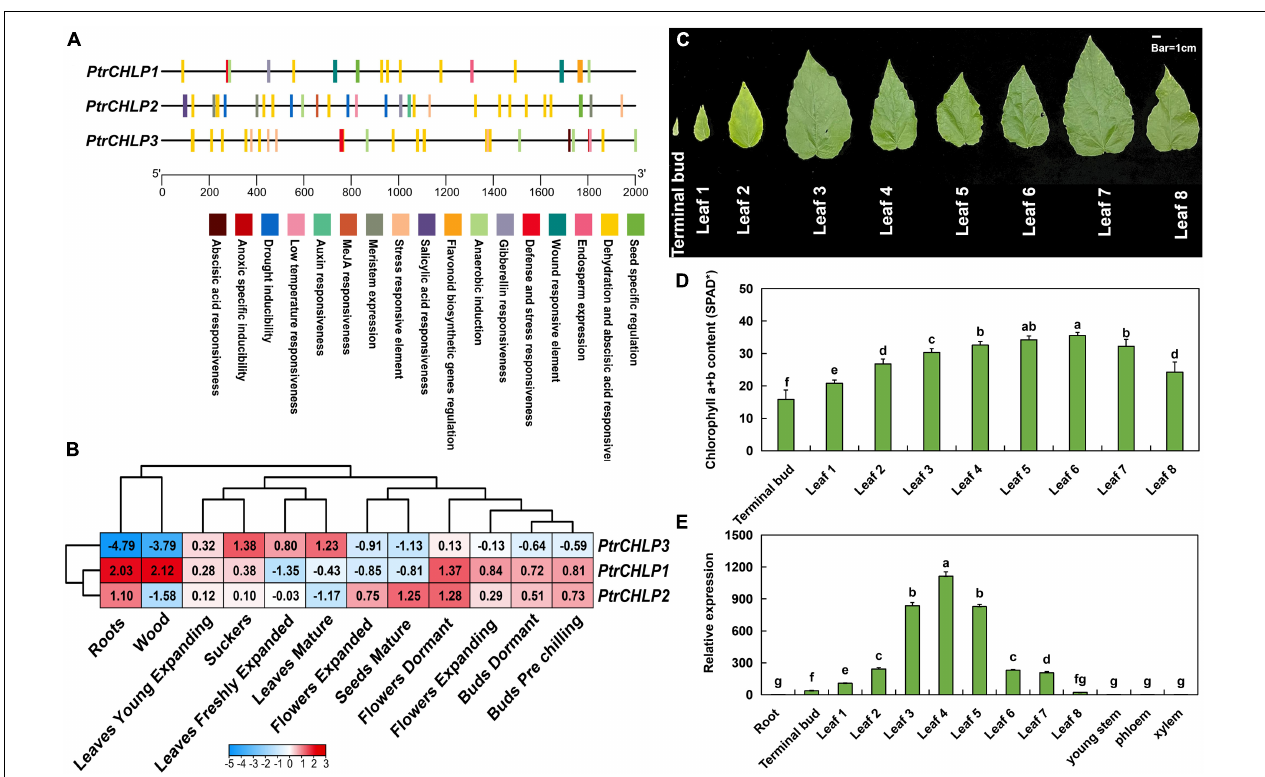
FIGURE 3 | Analysis of cis -acting regulatory elements and expression patterns of CHLPs in Populus . (A) Analysis of cis -acting regulatory elements of PtrCHLPs . The corresponding positions of cis -elements correlated with stress and growth in PtrCHLP promoter regions. Diverse colors indicate various cis -acting elements, and their regions conform to the homologous region of the promoter. (B) Heat maps represent the expression of PtrCHLP1-3 in different plant tissues at various growth stages. The color bars indicate the range of fold change in expression. The phenotype (C) and chlorophyll content (D) analysis of 30-day-old poplar leaves from top to base. (E) RT-qPCR analysis of the expression features of PtrCHLPs in different tissues. The bars indicate mean ± SD (n = 20) from five independent trials. Different letters above the bars indicate statistically significant differences (adjusted P < 0.05, one-way